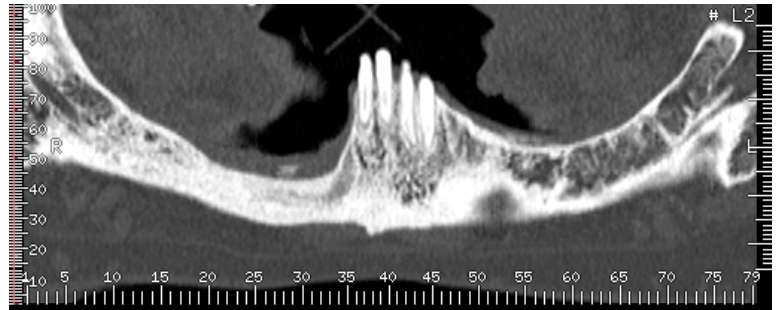
Figure 13. CT scan dated October 2016 showed no erosion of the mandibular buccal and lingual cortical bone.